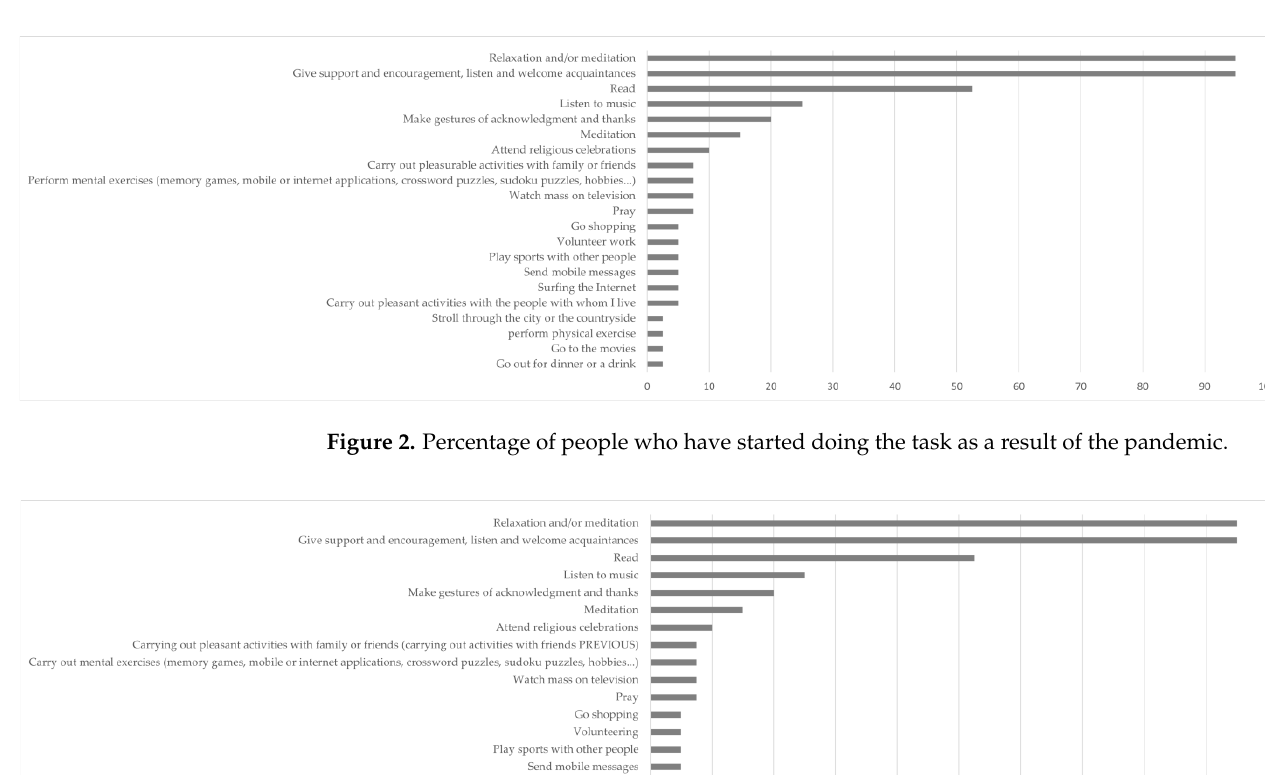
Figure 2. Percentage of people who have started doing the task as a result of the pandemic.